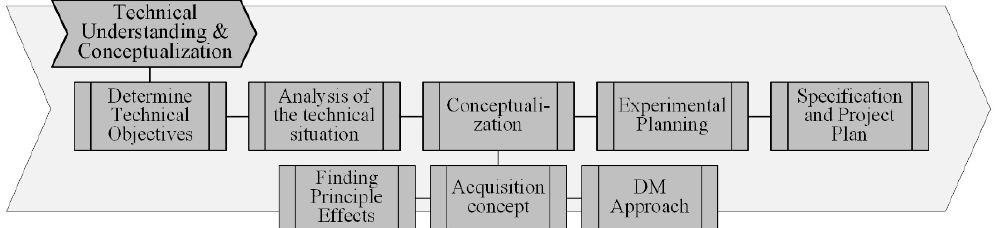
Figure 2. Tasks of the “Technical Understanding & Conceptualization” phase of the DMME reference model.